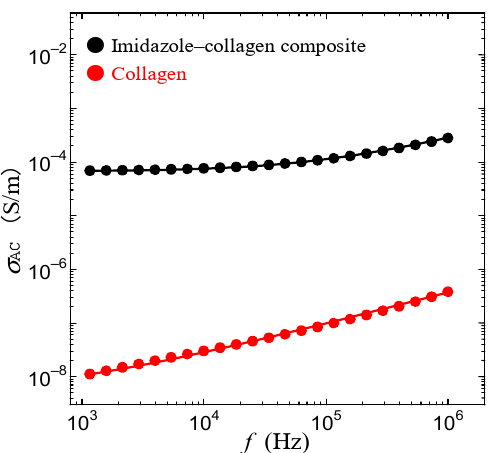
Figure 5. Temperature dependence of DTA curve in collagen ( a ) and imidazole–collagen composite ( b ).